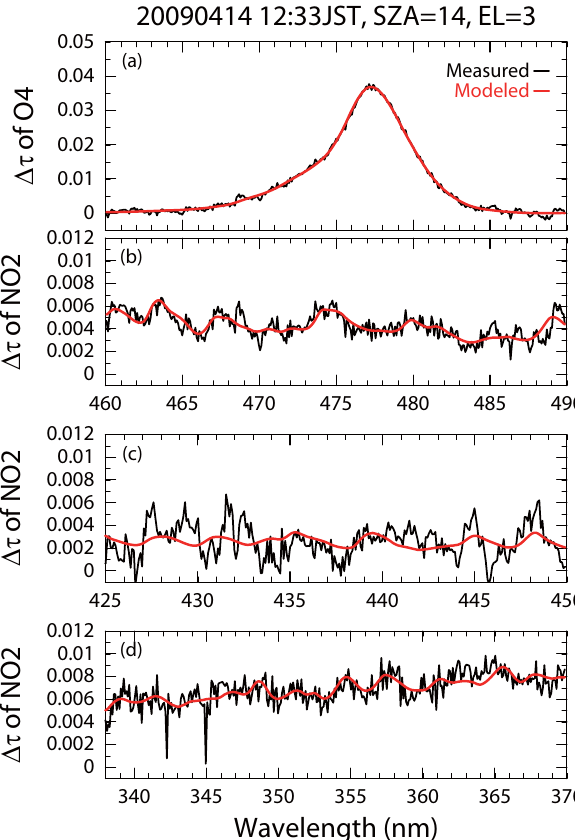
Fig. 6. Example of the result of nonlinear least squares spectral fit- ting for O 4 and NO 2 observed on 14 April 2009 on the R/V Kaiyo at 141.7 ◦ E, 11.1 ◦ N. For the NO 2 fittings, we used three fitting win- dows (460–490, 425–450, and 336–370nm, as shown in (b) , (c) , and (d) , respectively). The red line shows the cross-section scaled to the spectrum (black) measured by DOAS. The spectra are plotted in terms of differential optical depth from the reference spectrum (elevation angle of 70 ◦